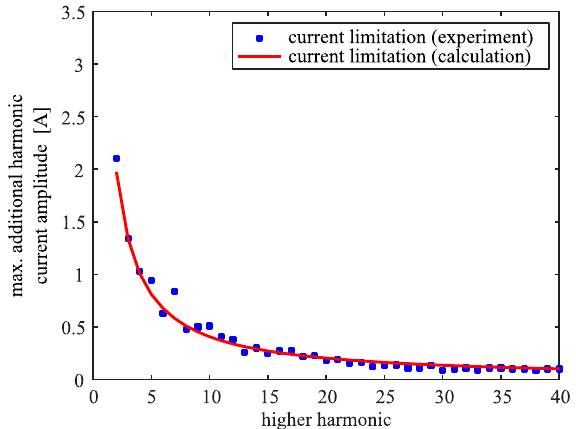
Figure 11. Comparison of the calculated (by Equation (15)) and experimental current limitations, based on load current containing fundamental harmonic with an amplitude of 10 A and third harmonic with amplitude of 1